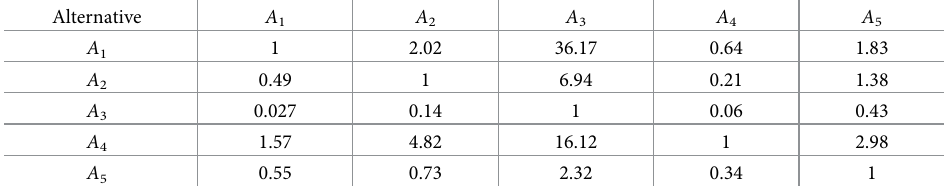
Table 5. Alternatives’ evaluation with respect to Definition 2 and Remark 1, a multiplicative preference matrix.